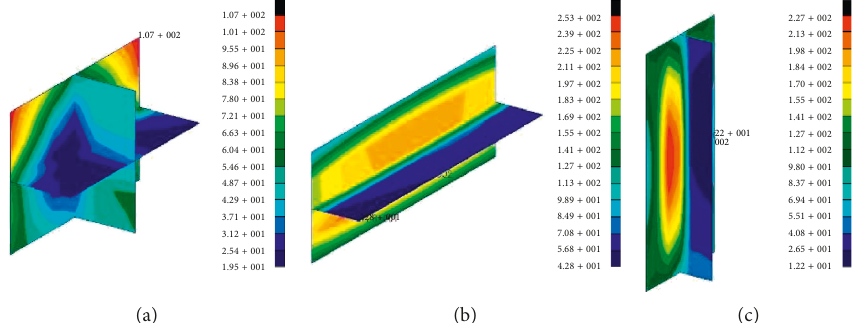
Figure 11: Structural analysis results on equivalent stress distribution of the (a) crucial joint, (b) horizontal stiffener, and (c) vertical stiffener.